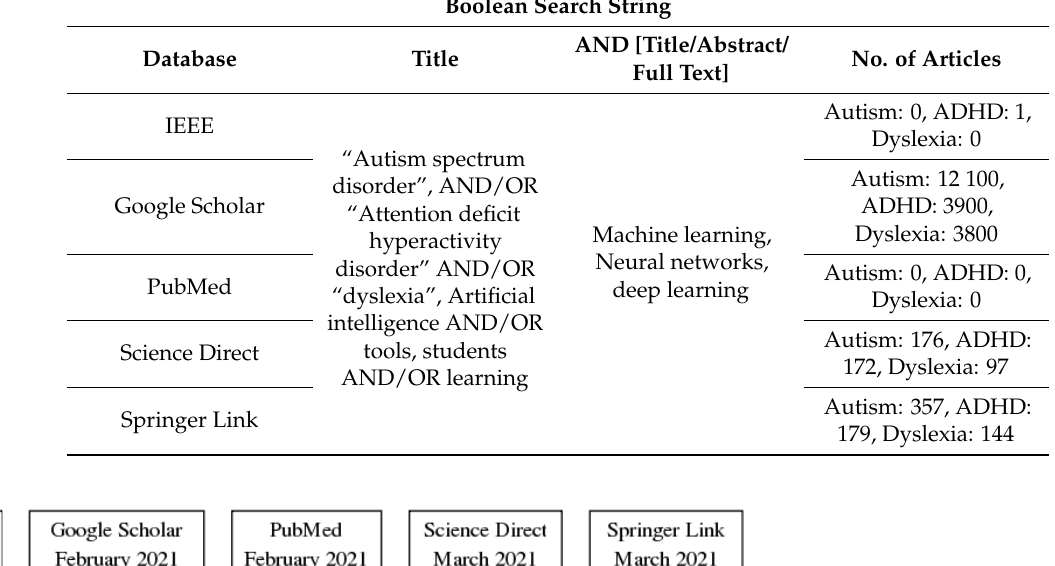
Table 4. Results of the Boolean search string for the respective repositories.